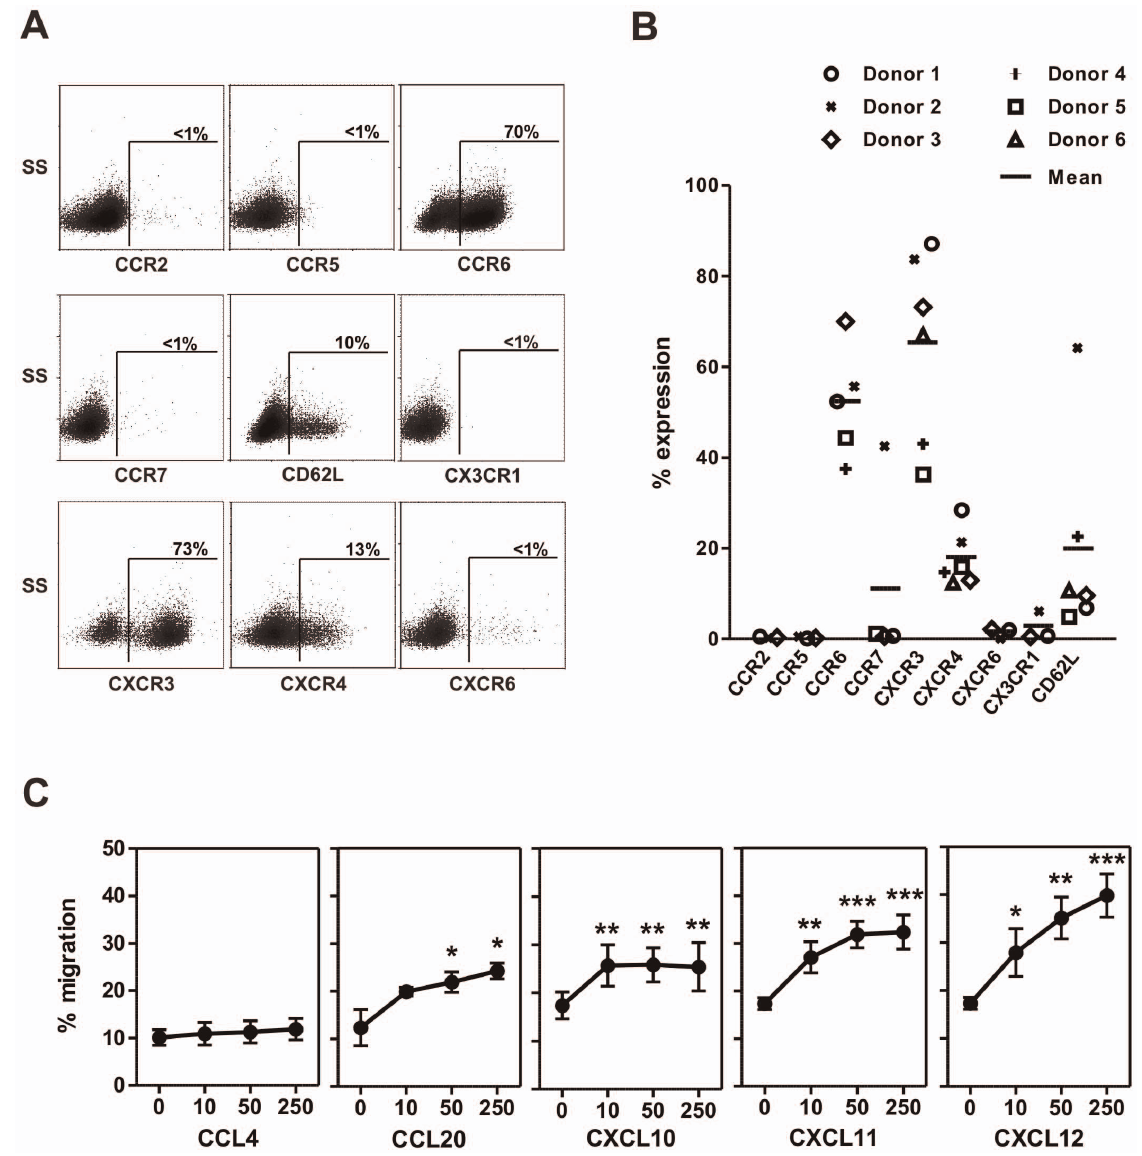
Figure 1. Homing receptor expression profile of UCB-NK cells. (A–B) The expression level of homing receptors was analysed by flow cytometry on UCB-NK cells at the end of the culture process. (A) Dot plots gated on CD56 + cells from one representative donor; (B) Summary of 6 different donors analysed. (C) The capacity of UCB-NK cells to respond in vitro to gradients (10 to 250 ng/ml) of the chemokines CCL4 (CCR5 ligand), CCL20 (CCR6 ligand), CXCL10, CXCL11 (both CXCR3 ligand) and CXCL12 (CXCR4 ligand) was evaluated in transwell migration assays as described in materials and methods. Mean 6 SEM of three independent experiments are shown, each performed with different UCB-NK cell donors. Migration towards specific chemokines was compared to non-specific migration (0 ng/ml) using a one way-ANOVA followed by Dunnett’s multiple comparison post-hoc test, * p , 0.05, ** p , 0.01, *** p , 0.001. doi:10.1371/journal.pone.0064384.g001 Mice were sacrificed (cervical dislocation) when the palpable fetal calf serum. Green fluorescent protein (GFP) and Luciferase tumor reached 1 cm in diameter or when one of the following expressing K562 cells (K562.LucGFP) were generated by stable criteria was observed: severe weight loss, poor coat and skin transduction of parental cells with lentiviral particles LVP20 condition, static activity or paraplegia. Leukemia load was encoding the reporter genes under control of the CMV promoter monitored by bioluminescence imaging (BLI) following injection (GenTech). To establish a preclinical AML xenograft model, adult of Luciferine (3.5 mg per mouse, Caliper Life Science) using the NSG mice were injected in their right femur with 10 5 IVIS system (Xenogen). Images were analyzed using Living Image K562.GFPLuc cells (injection volume = 5 m l), by insertion of a Software 2.5 (Xenogen). Leukemia load was quantified in the 25G Hamilton needle through the knee joint of isoflurane gas region of interest with subtraction of background signal, and anesthetized mice. Using this procedure, leukemia cell growth expressed as photons per second. For adoptive transfer, UCB-NK remained localized to BM up to 5 weeks. Thereafter, tumor cells cells were resuspended in PBS and injected i.v. via the tail vein of eventually overgrow outside the bone forming a palpable tumor.